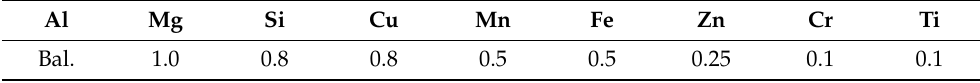
Table 1. The nominal chemical composition of commercial aluminum alloy 6013 (wt.%). Al Mg Si Cu Mn Fe Zn Cr Ti